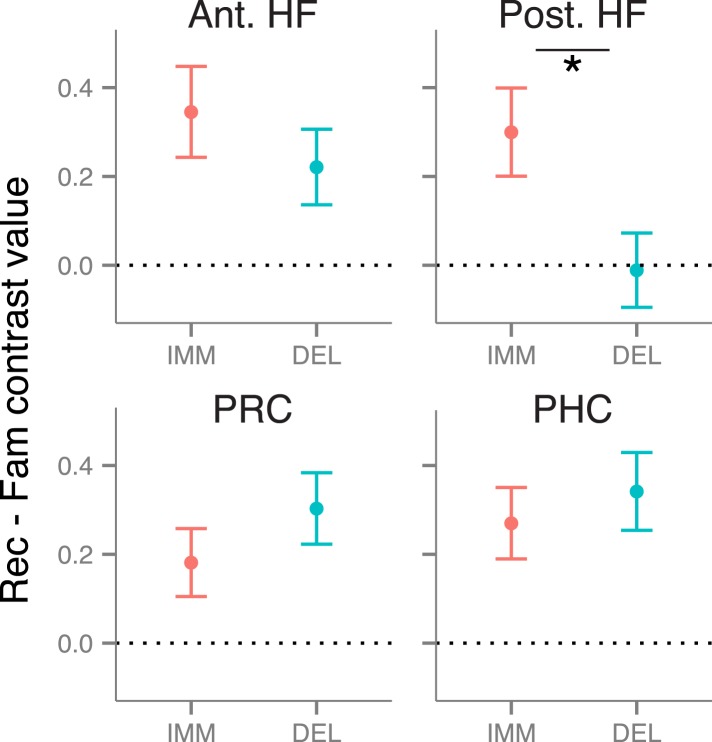
Recollection-related activity in the MTL.Univariate estimates of recollection-related activity (i.e., the difference in activation for recollection and familiarity trials) for left hemisphere MTL ROIs (similar results hold for right hemisphere ROIs; see Figure 2—figure supplement 1). Asterisk (*) denotes a significant interaction between delay (immediate, delayed) and memory status (recollection, familiarity), p < 0.05. Error bars denote the standard error of the mean. See Figure 2—figure supplement 2 for results from a model in which the number of recollection and familiarity trials were matched between delays. Summary statistics for individual subjects are contained in Figure 2—source data 1, and group-averaged activity estimates for all conditions can be found in Supplementary file 1.DOI:
http://dx.doi.org/10.7554/eLife.05025.00610.7554/eLife.05025.007Figure 2—source data 1.Activation estimates for MTL ROIs.